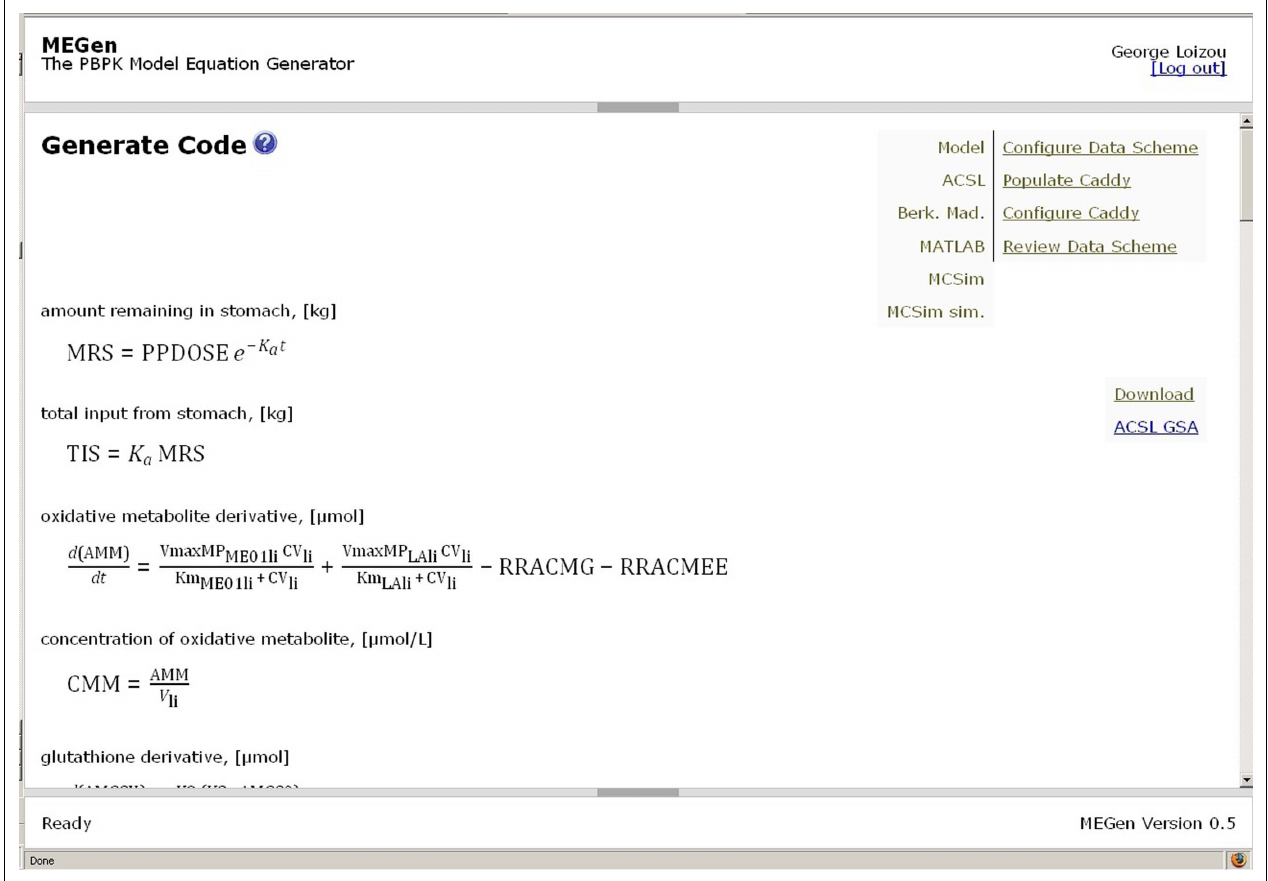
FIGURE 10 | Generate code